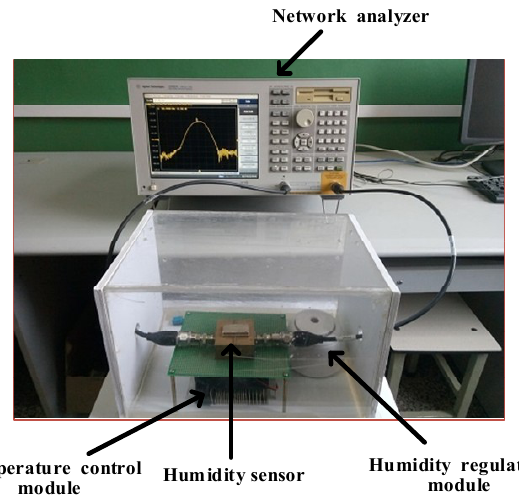
Figure 4. Part of the real measurement system.